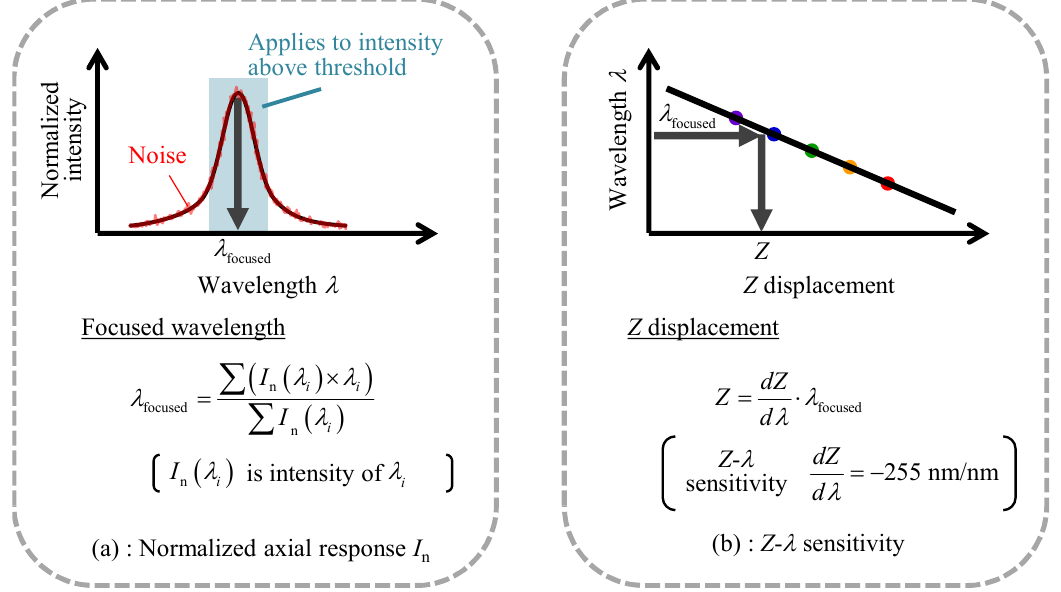
Figure 5. Principle of a method to obtain the Z displacement from the normalized axial response I n and Z-λ sensitivity: ( a ) Focused wavelength extracted from the normalized axial response I n ; ( b ) Z displacement calculated by using the Z-λ sensitivity.